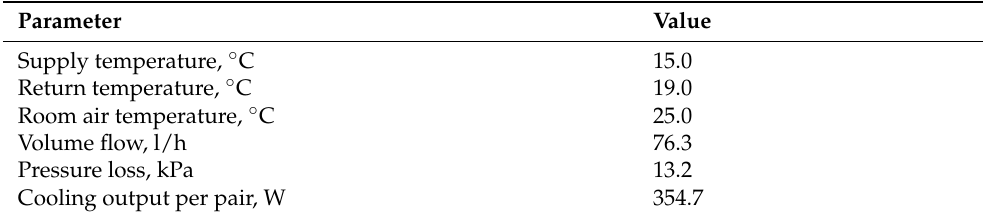
Table 2. Nominal operation parameters of a ceiling panels pair.